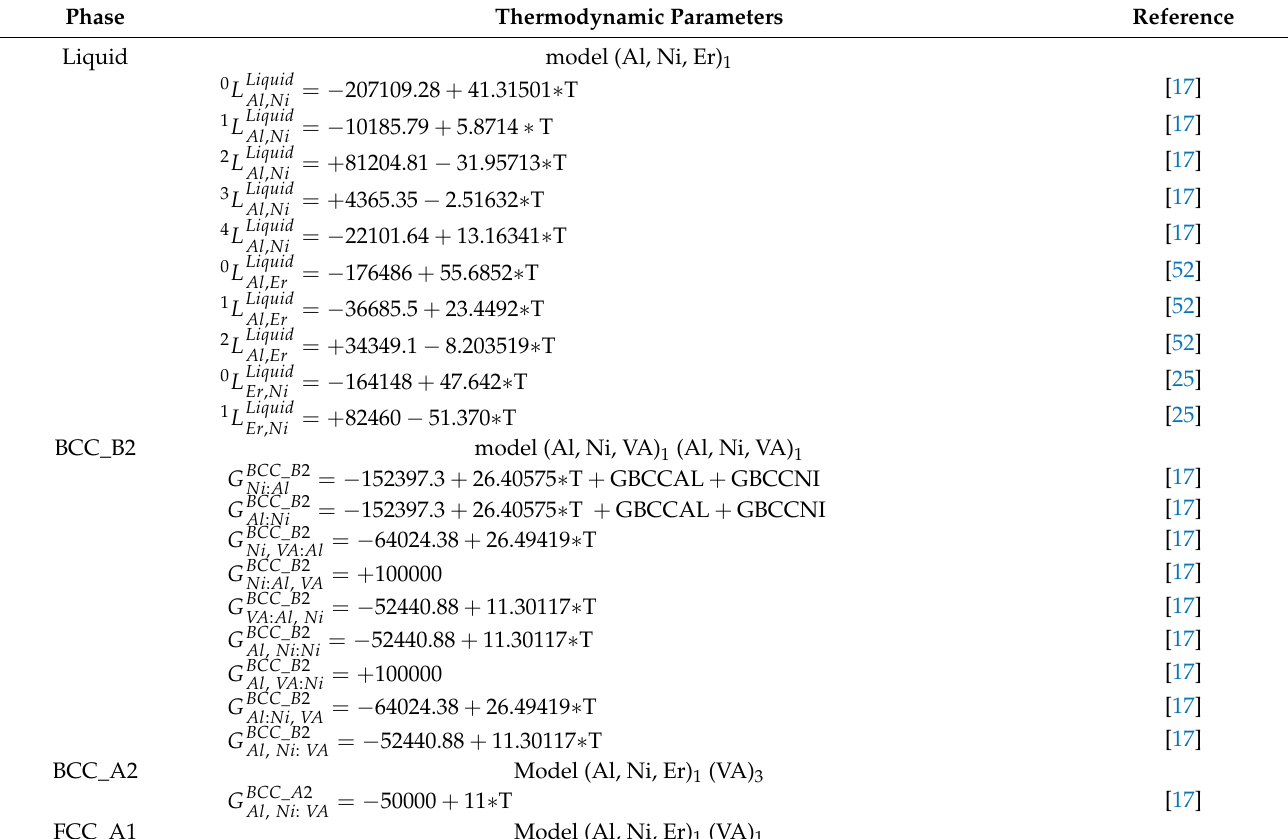
Table 6. Thermodynamic parameters of the Al–Ni–Er